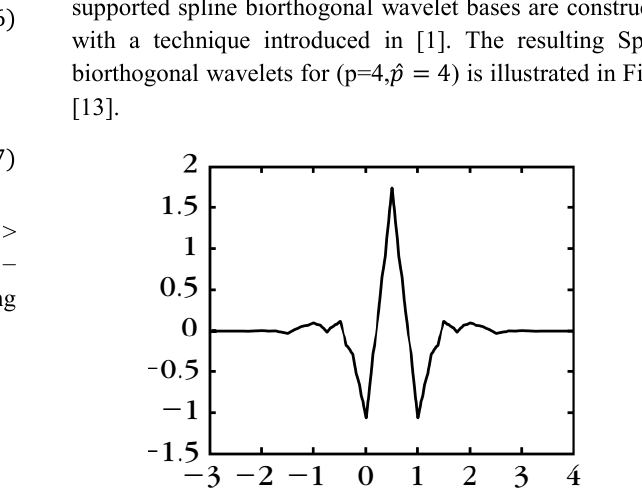
Figure 7 : Biorthogonal wavelet [13].